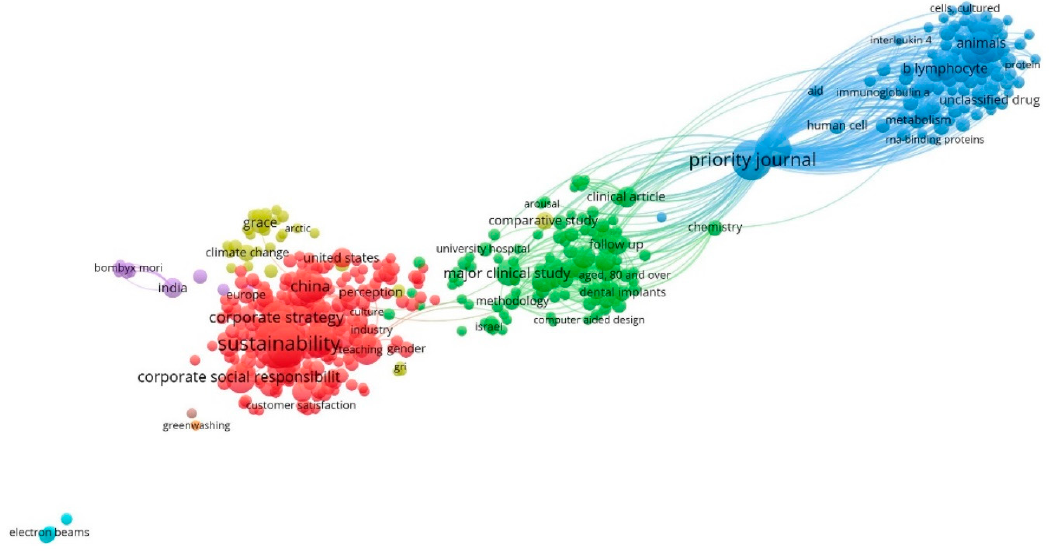
Figure 7. Keywords network based on co-occurrence (1970–2019).